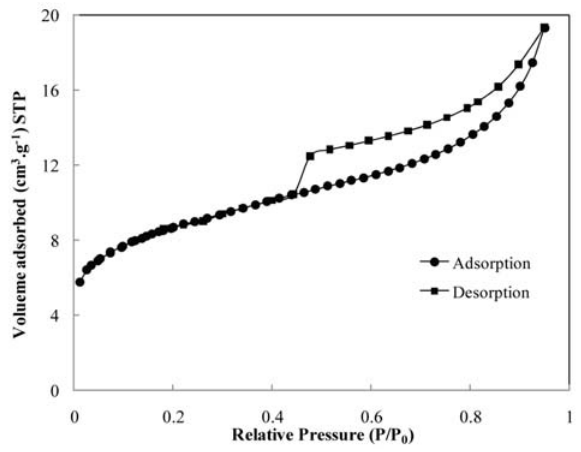
Figure 2 . N isotherm of FS clay 2